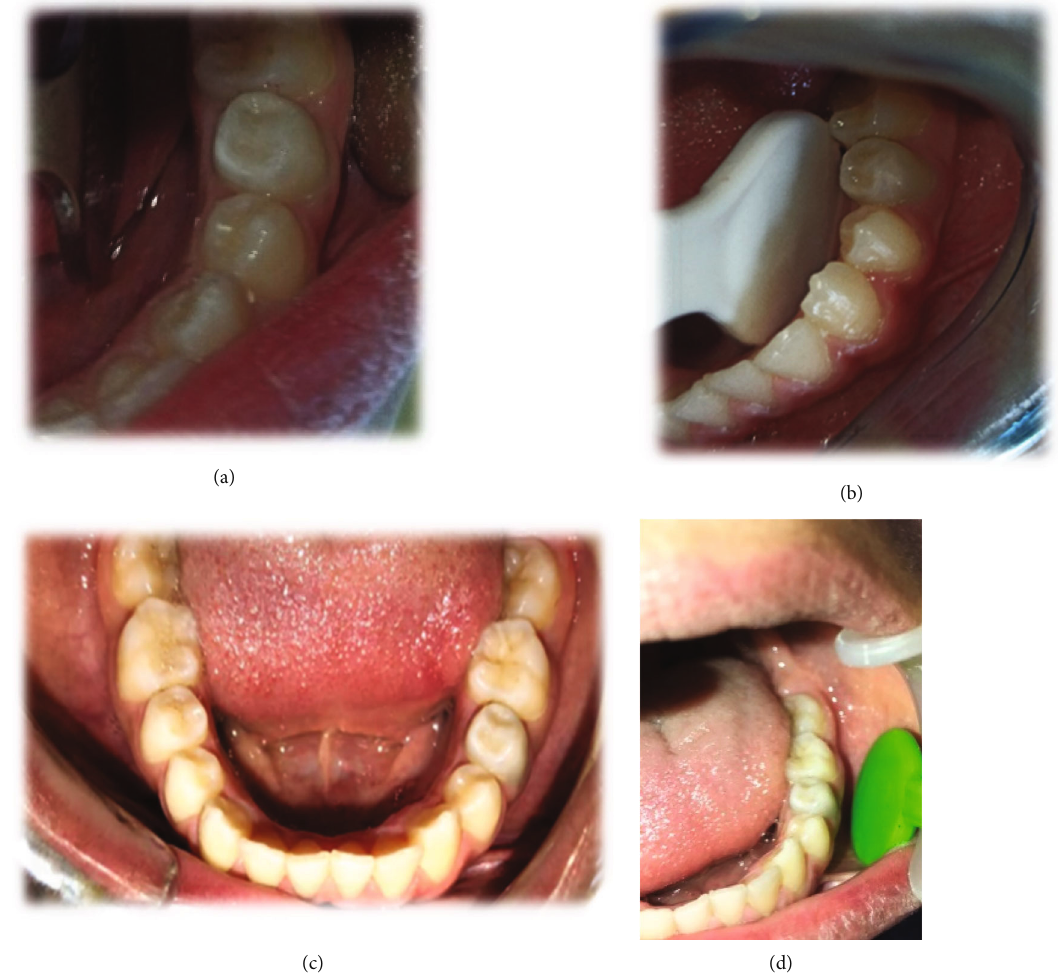
Figure 4: The postoperative photograph during follow-ups at months 3 (a), 6 (b), 12 (c), and 24